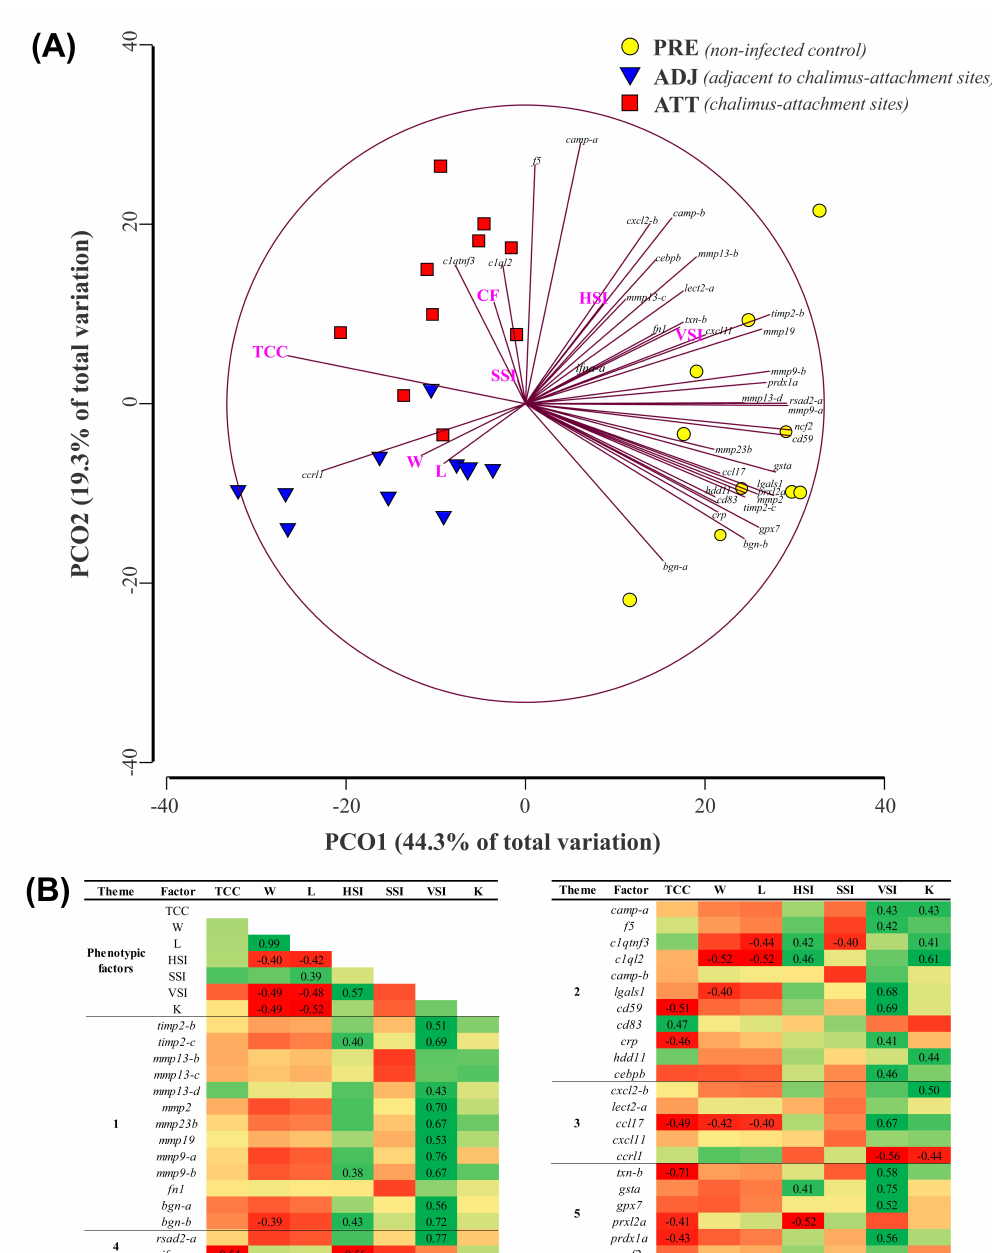
Figure 11. Principal coordinate analysis (PCoA) and correlation analysis of fin transcript expression data from QPCR with phenotypic factors. Standardized and log 2 -transformed data, respectively, were used in PCoA and correlation analyses. ( A ) Similarities and dissimilarities among treatment groups revealed by PCoA performed by PRIMER 6.1.15. ( B ) log 2 -transformed data were subjected to factor analysis using IBM SPSS Statistics (v25). Matrix represents the Pearson correlation coe ffi cients between 8 phenotypic factors (columns; e.g., chalimus count) and both fin gene expression and the phenotypic factors (rows). Positive and negative correlations are indicated with green and red, respectively. A number for the corresponding correlation is displayed if the correlation is significant ( p < 0.05). TCC, total chalimus count; W, weight; L, length; HSI, hepatosomatic index (HSI = 100 × (liver weight / W)); SSI, spleen-somatic index (SSI = 1000 × (spleen weight / W)); VSI, viscerosomatic index (VSI = 100 × (viscera weight / W)), and K, Fulton’s condition factor (K = 100 × (W / L 3